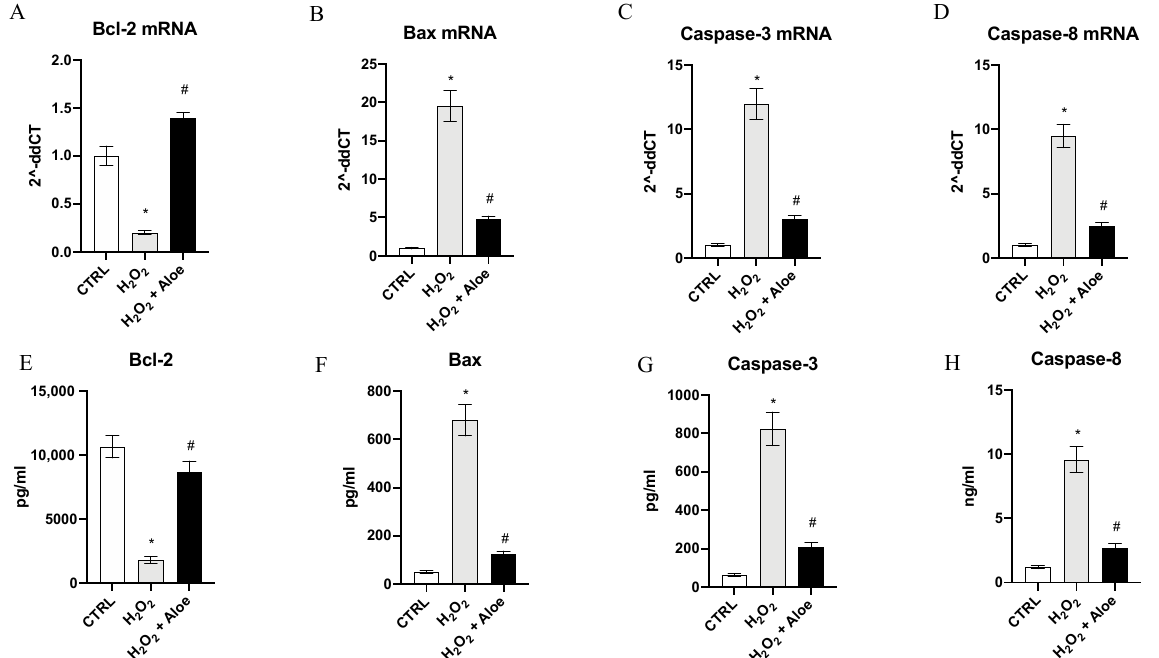
Figure 4. Effects of pre-treatment with aloe extract on Bcl-2 ( A ), Bax ( B ), Caspase-3 ( C ), Caspase-8 ( D ) mRNA expression. Effects of pre-treatment with aloe extract on Bcl-2 ( E ), Bax ( F ), Caspase-3 ( G ), Caspase-8 ( H ) levels. Values are expressed as the means ± SD. * p < 0.0001 vs. CTRL; # p < 0.0001 vs. H 2 O 2 .